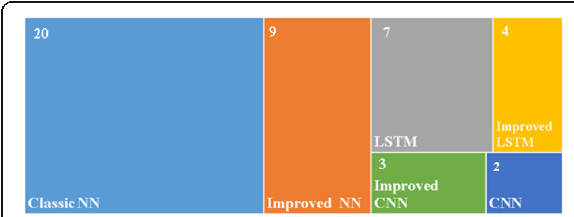
Fig. 7 Number of investigations for the different types of ANN- based models for SST